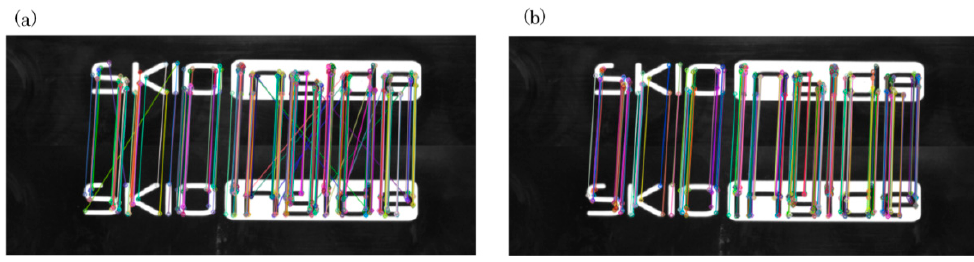
Figure 10. Feature matching result between reference image and image in scene; ( a ) Keypoints matching result based on ordinary method; ( b ) Keypoints matching result based on spatial consistency.